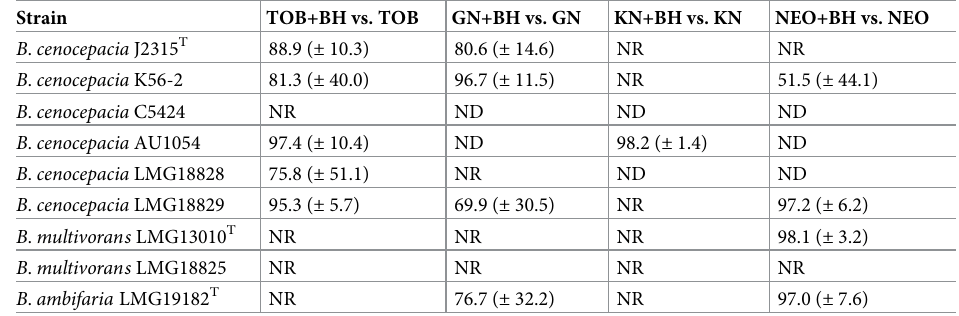
Data shown are percentage reduction in CFU/ml (±SD) when combination treatment is compared to the antibiotic alone (n = 3). NR, no significant reduction in CFU/ml when BH is added to the antibiotic treatment (p > 0.05). ND, not determined because MIC > 1024 μg/ml. Tobramycin (TOB) + BH (TOB+BH), gentamicin (GN) + BH (GN +BH), kanamycin (KN) + BH (KN+BH) and neomycin (NEO) + BH (NEO+BH).